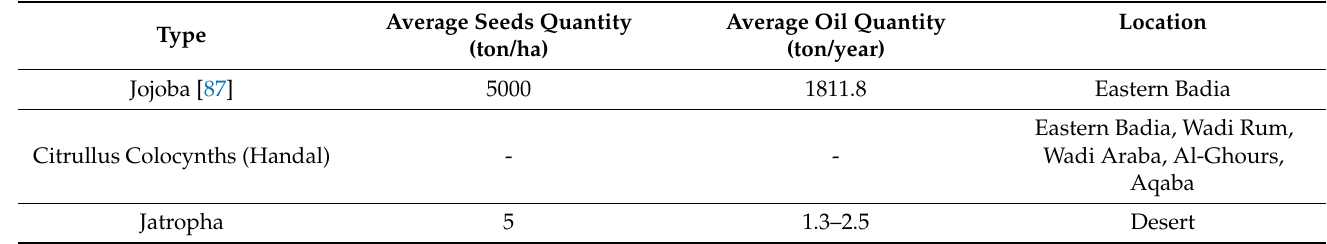
Table 8. Nonedible plants in Jordan.